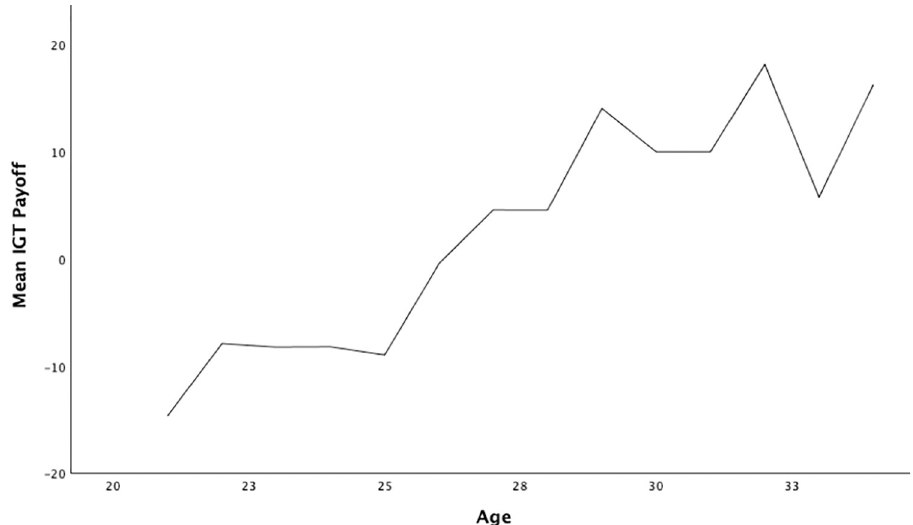
Fig 1. IGT payoff trend over 21–34 years old study sample.